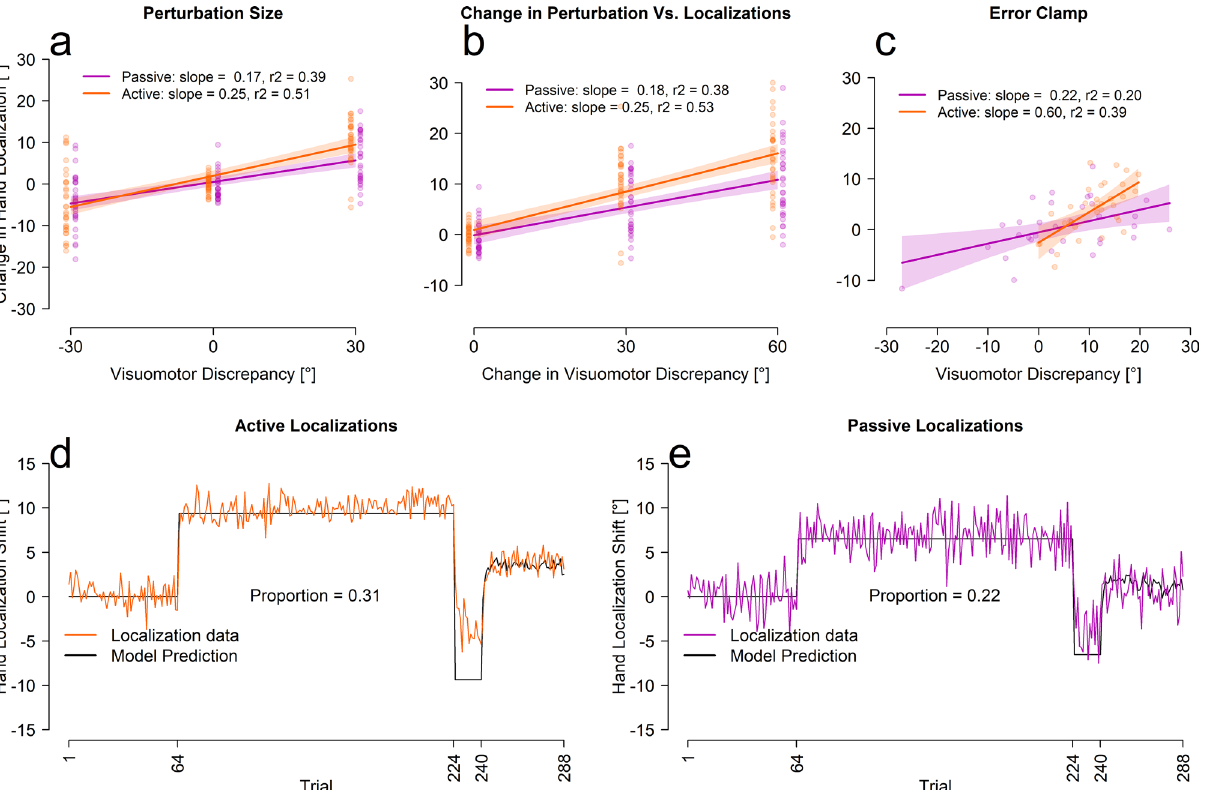
Figure 3. Linear and proportional fits between localization and error clamp trials. ( a–c ) Fits between localizations and either the size of the visual discrepancy (aligned = 0, first rotation = 30, second rotation = − 30), the absolute change in size of visual discrepancy (aligned = 0, first rotation = 30, second rotation = 60) and the participants average performance on the final 16 error clamp trials. The shaded regions represent the 95% confidence interval around the regression line. The last four initial rotation trials, the last four reversal trials and the last four aligned training trials were used for figures ( a,b ). ( d,e ) The proportional models’ prediction and the averaged participant performance for each localization test trial